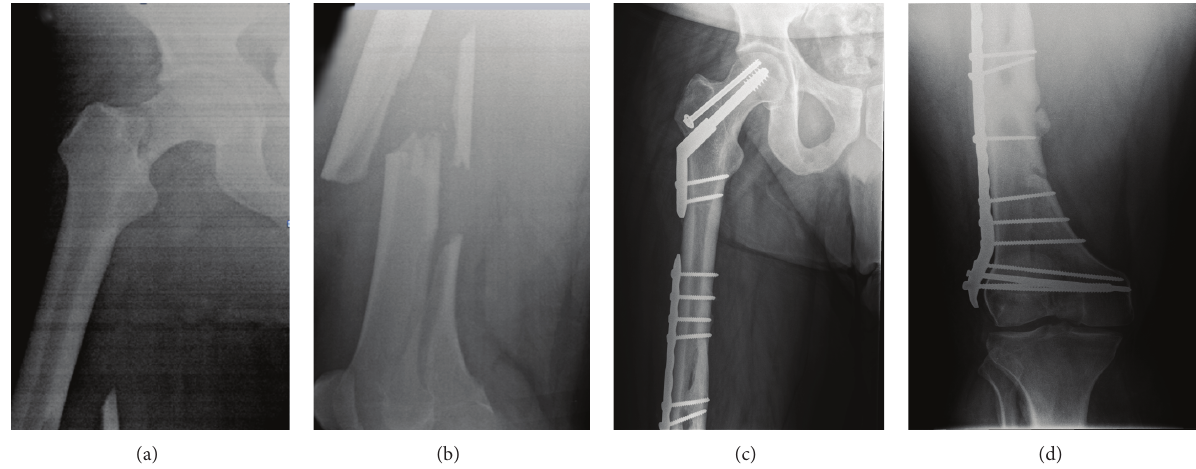
Figure 1: Case Report 1: (a)-(b) preoperative images, (c)-(d) postoperative images. The proximal fracture was reduced and stabilised using a two-hole plate dynamic hip screw with a derotation screw. An extended lateral approach was then used to reduce and stabilise the distal fractures with a 16-hole locking